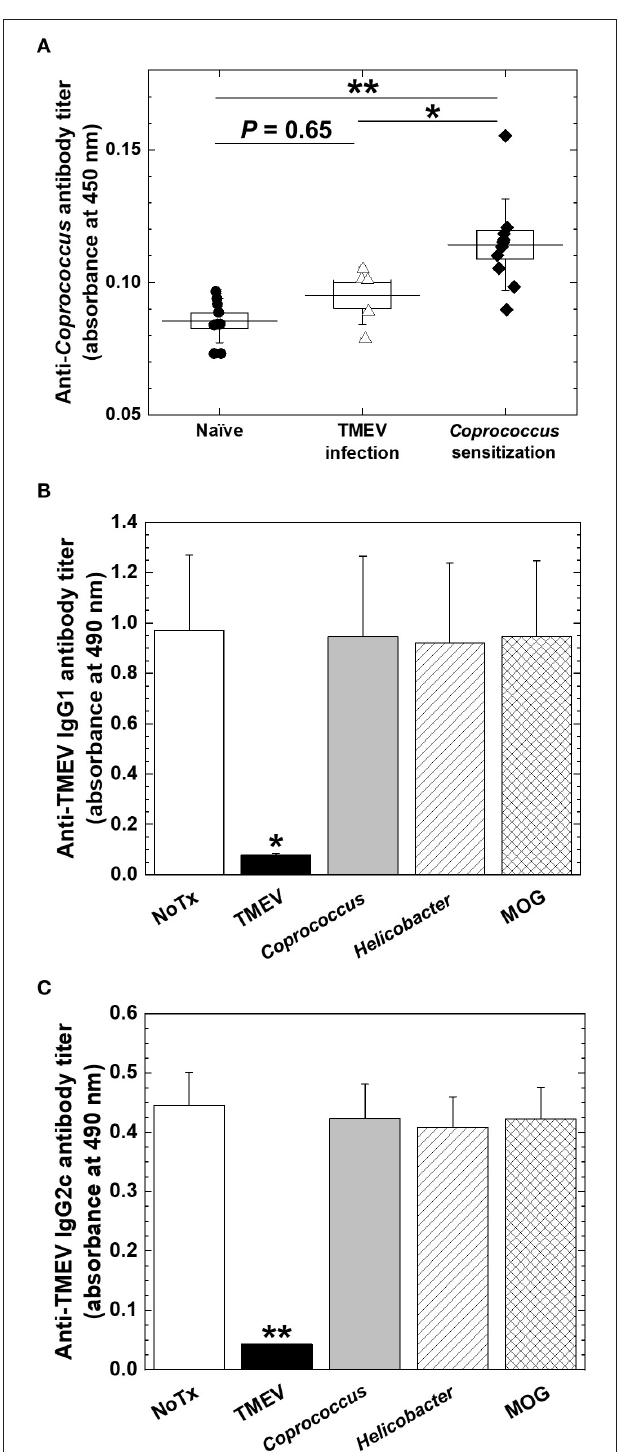
FIGURE 9 | Anti- Coprococcus antibody responses in TMEV infection. (A) Using ELISA plates coated with Coprococcus antigen, we titrated serum anti- Coprococcus antibody responses in naive mice ( n = 7), chronically TMEV-infected mice ( n = 5), and Coprococus -sensitized mice ( n = 10). We